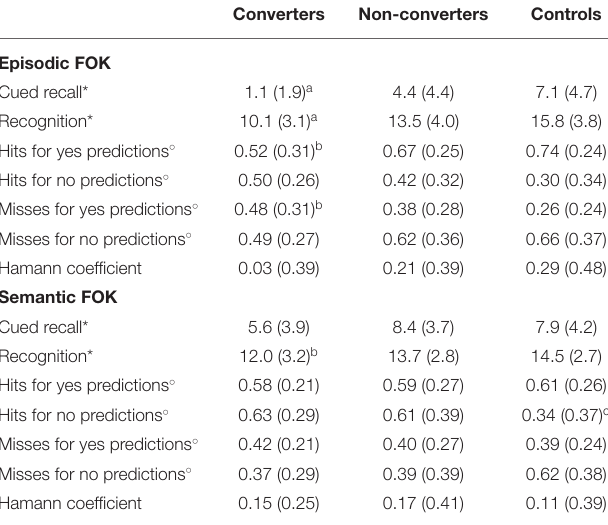
TABLE 3 | Feeling-of-knowing scores. Converters Non-converters Controls